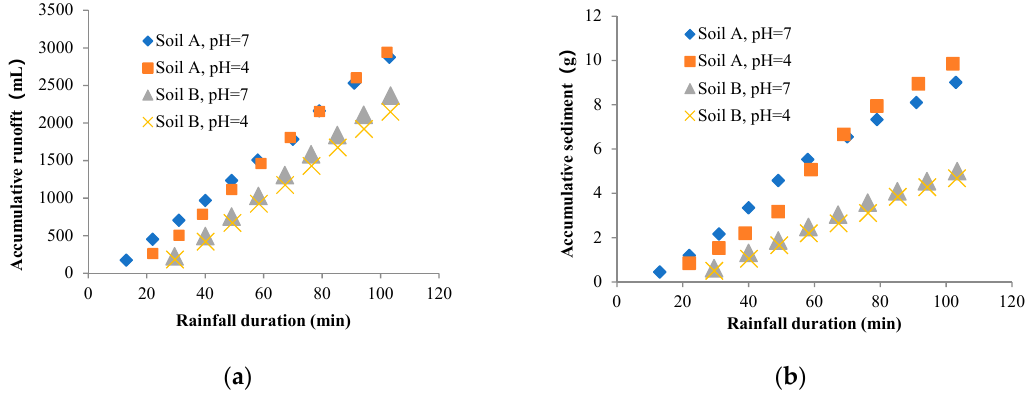
Figure 3. Accumulative ( a ) runoff (mL), and ( b ) sediment (g) collected from soil A and soil B during the simulated-rainfall experiments under acid (pH = 4) or neutral (pH = 7) rainfall.